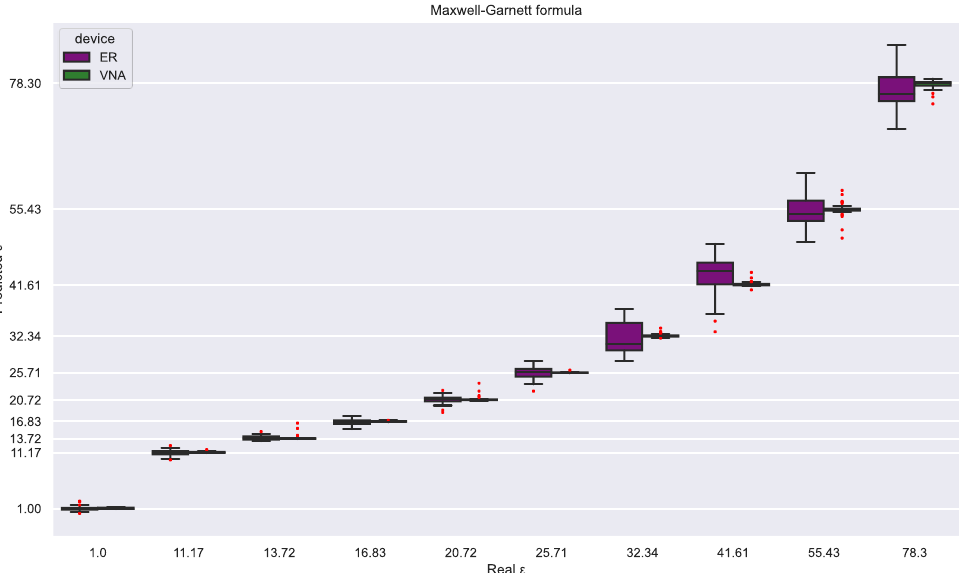
Figure 13. Permittivity estimations for both devices from an SVR model trained with the permittivity values from the Maxwell–Garnett mixing rule.